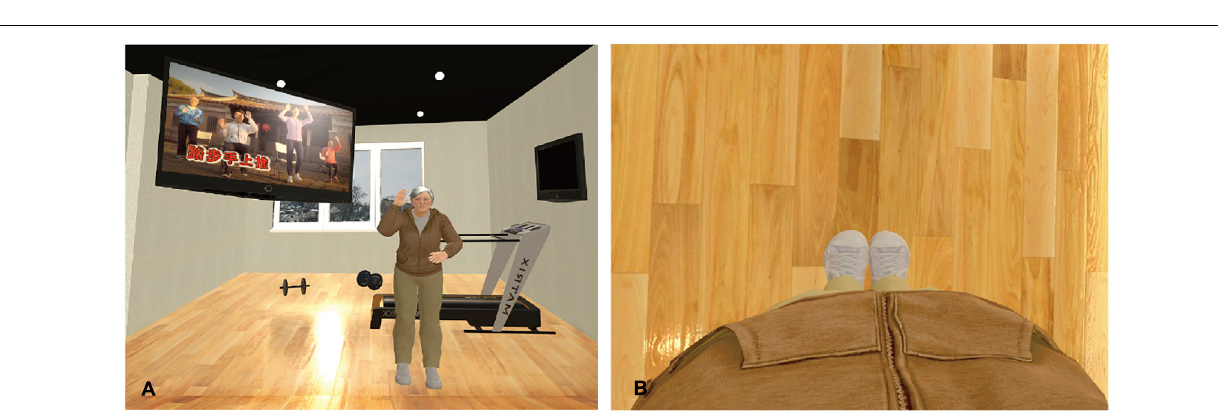
Frontiers in Psychology |